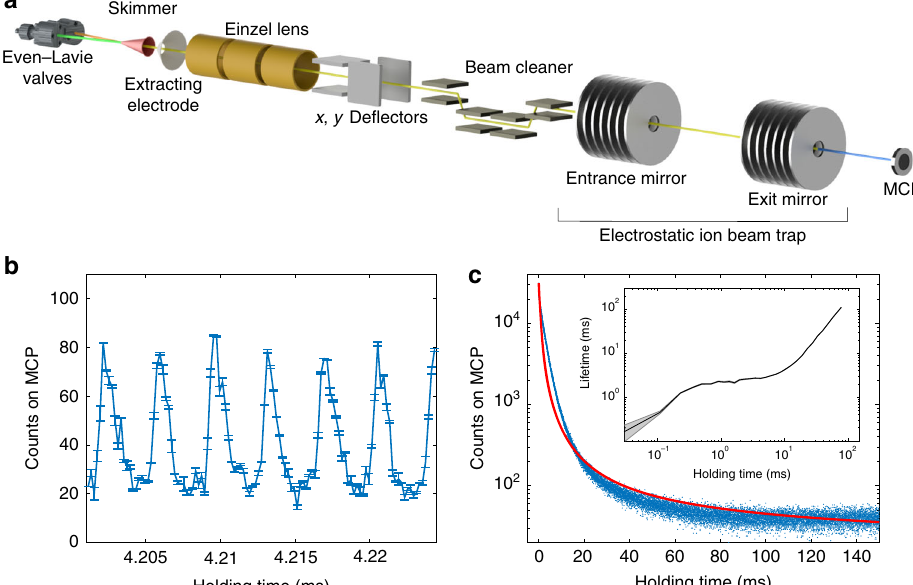
Fig. 4 EIBT experiment and results. a Experimental setup used to produce and trap a beam of NeAr + and detect the neutral decay products over time. b , c Neutral product count vs time, after 22,500 injections binned with 2 × 10 − 7 s ( b ) and 1 × 10 − 5 s ( c ). The inset in c shows the local lifetime observed during the non-exponential decay with the standard error indicated by the shaded area. The red curve in c is the theoretical prediction for the number of molecular ions as a function of time, with the initial populations estimated by an approximate overlap argument as explained in the Methods